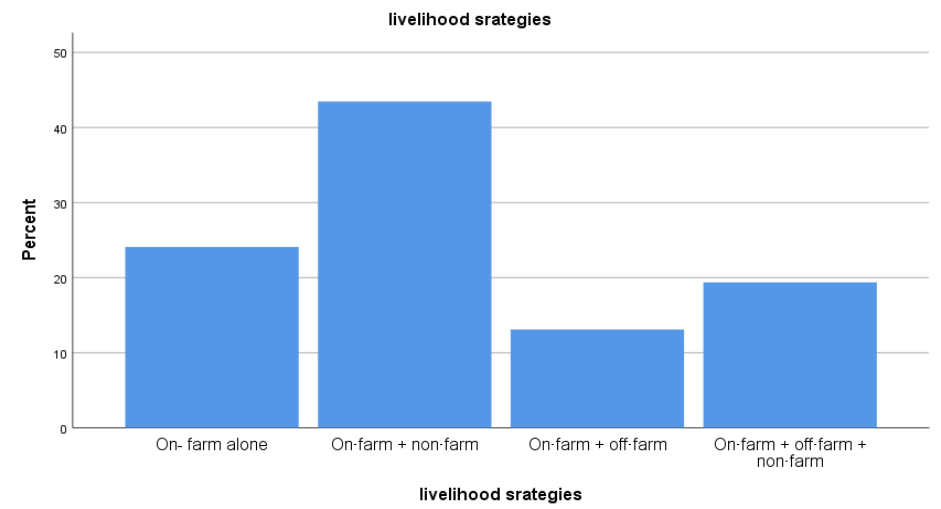
Figure 2. Choice of livelihood-diversification strategies adopted by the irrigation farmworkers. Source: Research survey, 2020.